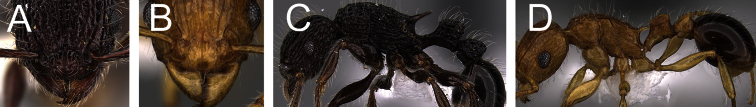
A, B Head in full-face view. A
Tetramorium capillosum (CASENT0901156) B
Tetramorium tabarum (CASENT0316967) C, D Body in profile. C
Tetramorium capillosum (CASENT0316960) D Tetramorium tabarum (CASENT0316967).